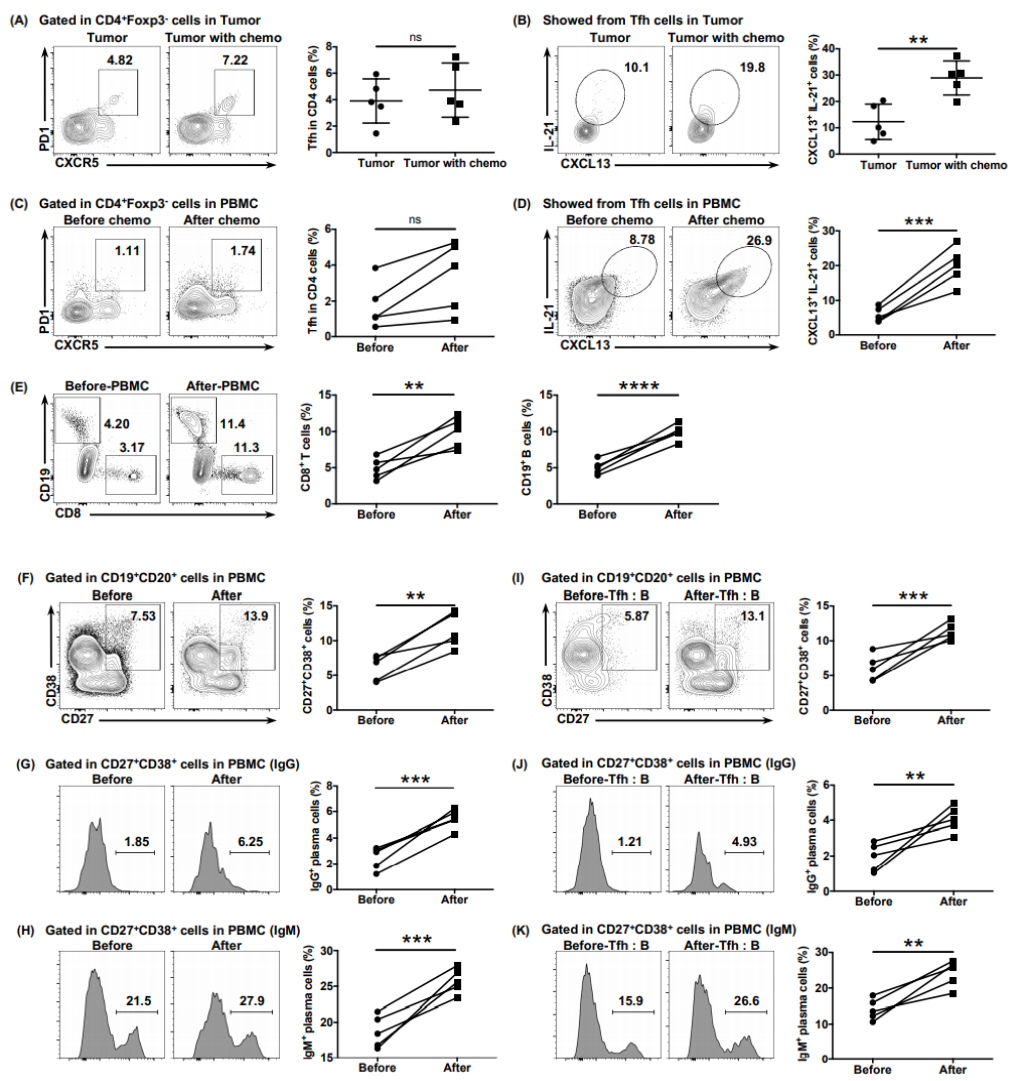
Figure 6. Neoadjuvant chemotherapy rescues the impaired function of Tfh cells. ( A ) Representative flow cytometry data and the proportion of total tumor-infiltrating Tfh cells (CD4 + CXCR5 + PD1 + ) from the tumor tissues of patients with PDAC with ( n = 5) or without ( n = 5) neoadjuvant chemotherapy. ( B ) Representative flow cytometry data and the proportion of functional tumor-infiltrating Tfh cells (CXCL13 + IL-21 + ) from the tumor tissues of patients with PDAC with ( n = 5) or without ( n = 5) neoadjuvant chemotherapy. ( C ) Representative flow cytometry data and ( F ) the proportion of total cTfh cells (CD4 + CXCR5 + PD1 + ) from the peripheral blood of patients with PDAC ( n = 5) before or after receiving neoadjuvant chemotherapy. ( D ) Representative flow cytometry data and ( H ) the proportion of functional cTfh cells (CXCL13 + IL-21 + ) from the peripheral blood of patients with PDAC ( n = 5) before or after receiving neoadjuvant chemotherapy. ( E ) Representative flow cytometry data and the proportion of CD8 + T cells and B cells recruited to the bottom of the Transwell chamber by the cTfh cells of patients with PDAC ( n = 5) before or after receiving neoadjuvant chemotherapy. ( F ) Representative flow cytometry data and the proportion of plasma cells (CD27 + CD38 + ) in B cells (CD19 + CD20 + ) from the peripheral blood of patients with PDAC ( n = 5) before or after receiving neoadjuvant chemotherapy. ( G ) Representative flow cytometry data and the proportion of IgG-secreting plasma cells from the cells in ( F ). ( H ) Representative flow cytometry data and the proportion of IgM-secreting plasma cells from the cells in ( F ). ( I ) Representative flow cytometry data and the proportion of plasma cells (CD27 + CD38 + ) in B cells (CD19 + CD20 + ) co-cultured with cTfh cells sorted from the peripheral blood of patients with PDAC ( n = 5) before or after receiving neoadjuvant chemotherapy. ( J ) Representative flow cytometry data and the proportion of IgG-secreting plasma cells from the cells in ( I ). ( K ) Representative flow cytometry data and the proportion of IgM-secreting plasma cells from the cells in ( I ). Asterisks indicated the significance level of the p -value (ns: no significant difference, ** p < 0.01, *** p < 0.001 and **** p <